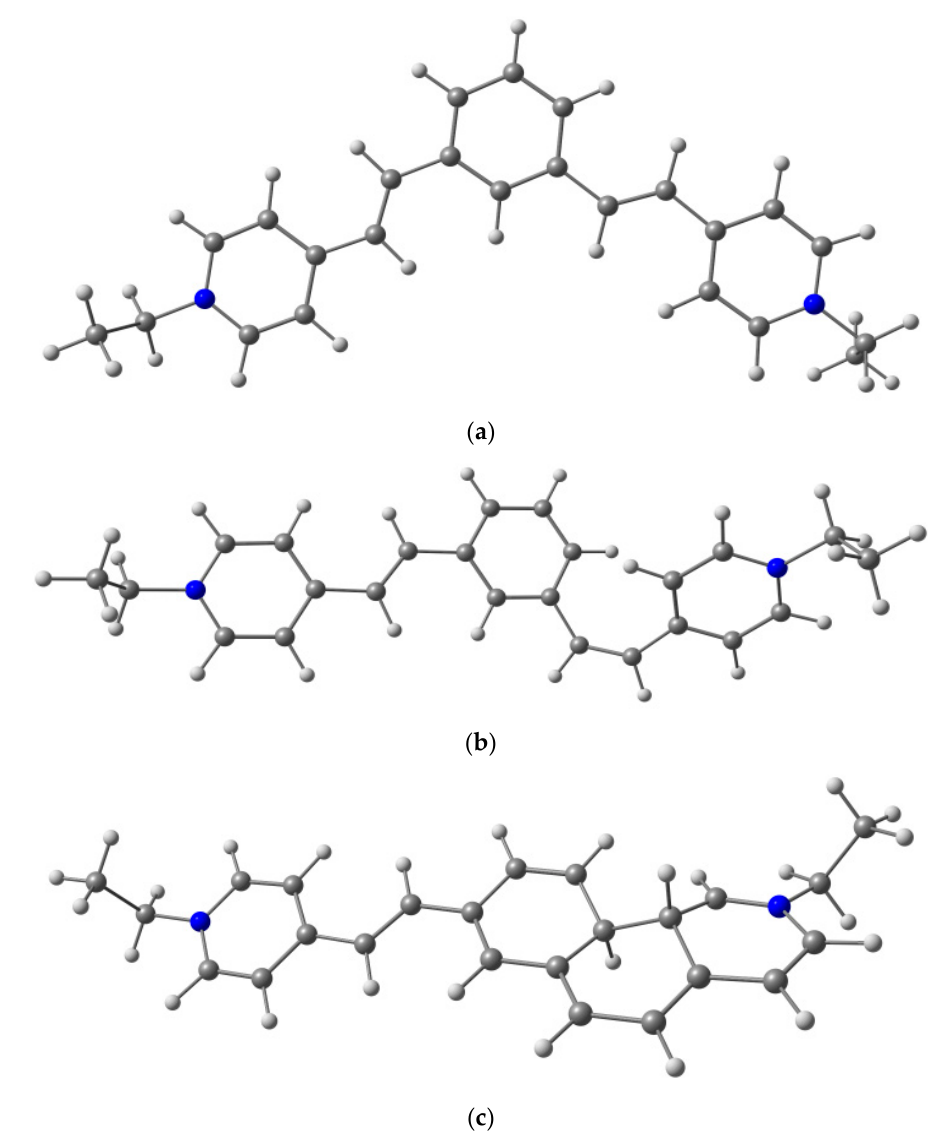
Figure 11. Structures of ( a ) trans- 2 and ( b ) cis- 2 and ( c ) its electrocyclization product dihydrophenanthrene DHP - 2 .